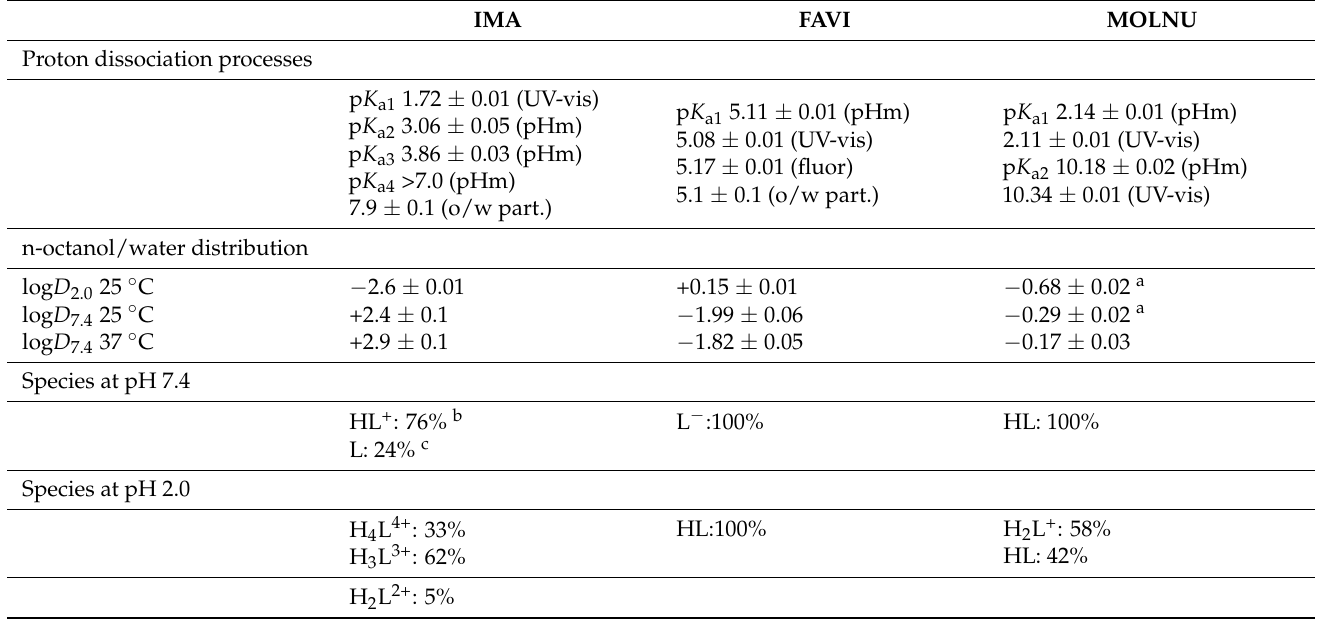
Table 1. Proton dissociation constants (p K a ) of the studied compounds determined by pH- potentiometry (pHm) UV-vis, fluorometry (fluor) or n -octanol/water partition (o/w part.), n -octanol/water distribution coefficients (log D pH ), and calculated distribution (%) of the species in different protonation states at pH 7.40 and 2.0 [ I = 0.1 M (KCl); t = 25 ◦ C]. IMA FAVI